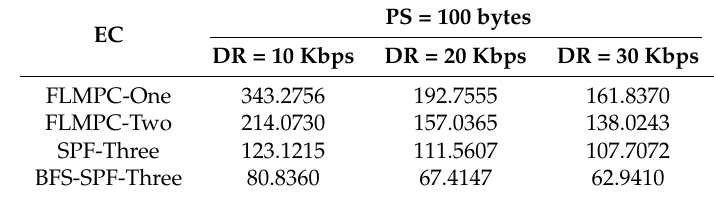
Figure 11. EC with Different PSs and DRs. Table 5. EC Values with PS of 100 bytes.